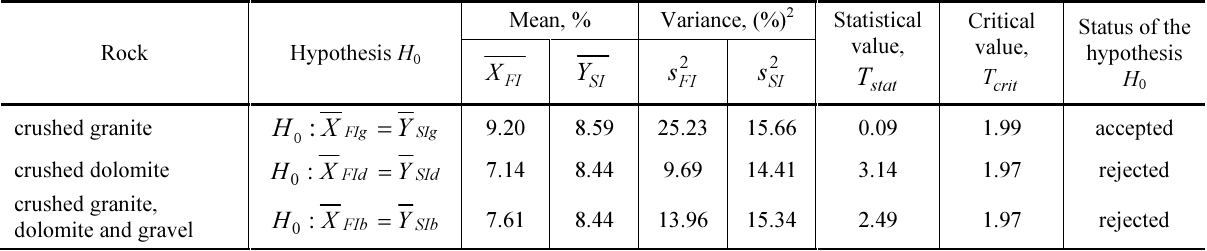
Table 7. Summary of hypotheses for the proximity of indexes FI and SI of the average values of granite dolomite and gravel